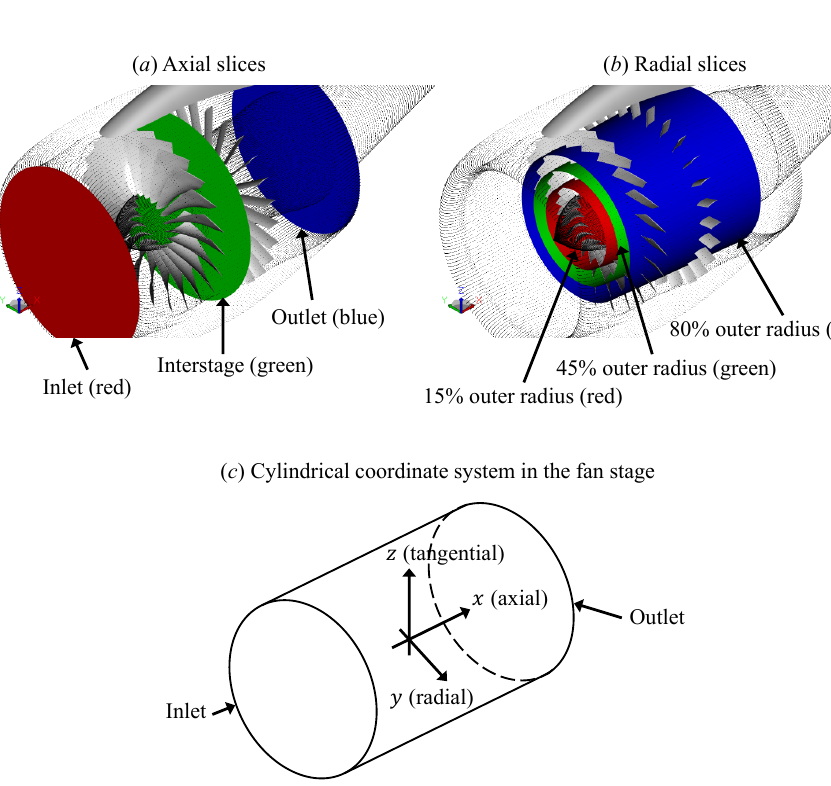
Figure 8. A sketch of the slice planes where contours are plotted in the subsequent figures: ( a ) axial slices and ( b ) radial slices. The cylindrical coordinate system in the fan stage is described in ( c ). Firstly, the phase-locked mean velocity magnitude contours on the axial slices are pro- vided in Figure 9. The usage of phase-locked statistics allows for emphasizing the periodic flow phenomena at each fan blade passage. Note that the phase-locked average velocity magnitude values (cid:104)|| U ||(cid:105) are normalized against a reference velocity U ref = 237.57 m/s, which is the average fan tip speed. As there is an incidence angle between the airframe and the incoming flow, the velocity distribution at the fan-stage inlet is not uniform; the flow at the lower side of the fan stage has a higher velocity than that at the upper side. The average velocity magnitude for the M800 and M450 configurations is slightly lower than in the baseline case, indicating that the air intake at the inlet decreases due to the poro-serrated OGVs. The mean flow field at the interstage is characterized by a spiral pattern due to the swirl induced by the fan rotation. At this location, the mean velocity is, on average, lower for the M800 and M450 configurations, although the swirling patterns do not appear to be affected by the presence of the poro-serrated OGVs. A more noticeable discrepancy can be found at the outlet of the fan stage, where the velocity magnitude near the hub for the M800 case is around 10 % lower than that of its baseline counterpart. On the other hand, the reduction of the mean velocity is less severe for the M450E configuration due to the limited spanwise extent of porous LE treatment. Given that the fan RPM is identical for all cases, it is reasonable to deduce that the poro-serrations have introduced a stronger flow resistance, which results in the thrust reduction discussed